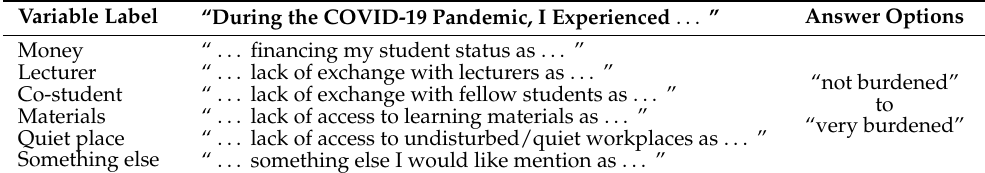
Table 1. Items for assessing study conditions.